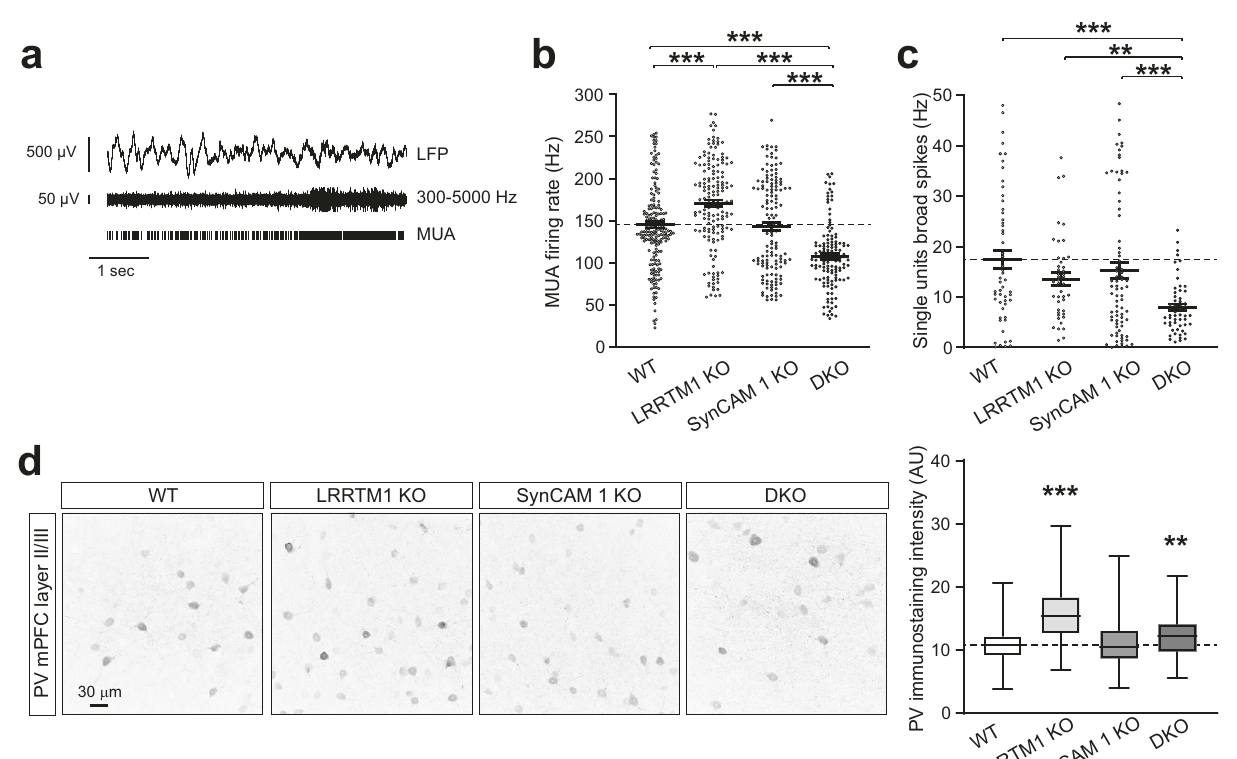
Fig. 4 | Aberrant neuronal activity in the mPFC of mice lacking LRRTM1 and SynCAM 1. a Multi-unit activity (MUA, middle and bottom traces) was extracted from band-pass fi ltered local fi eld potentials (LFPs, top trace) recorded from layer II/III of the mPFC of awake mice. MUA recordings encompass fi ring of excitatory and inhibitory neurons. b Single LRRTM1 loss elevates MUA fi ring rate and com- bined loss of LRRTM1 and SynCAM 1 reduces it. Firing rate was calculated as average spiking rate over time (in sec) recorded from mice around P50 as in a . (Kruskal-Wallis ANOVA with Dunn ’ s post hoc test; n =199 traces from 5 WT mice, 160tracesfrom4LRRTM1KO,137tracesfrom3SynCAM1KO,and132tracesfrom 3 DKO). c Analysis of single unit responses shows fewer broad spikes associated withthe fi ringofprincipalcellsinmicelackingbothLRRTM1andSynCAM1,butnot insingleKOmice.(One-wayANOVAwithDun ’ sposthoctest; n =54unitsfromWT,